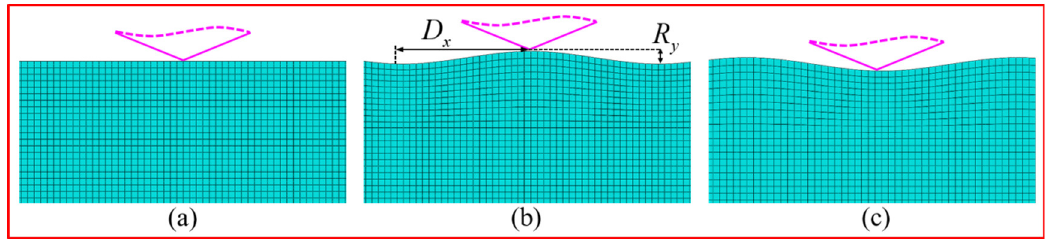
Figure 6. Partial magnification of contact positions. ( a ) smooth surface; ( b ) crest; ( c ) trough. The half-wavelength D x is 100 μm and the vertical height R y is 10 μm.